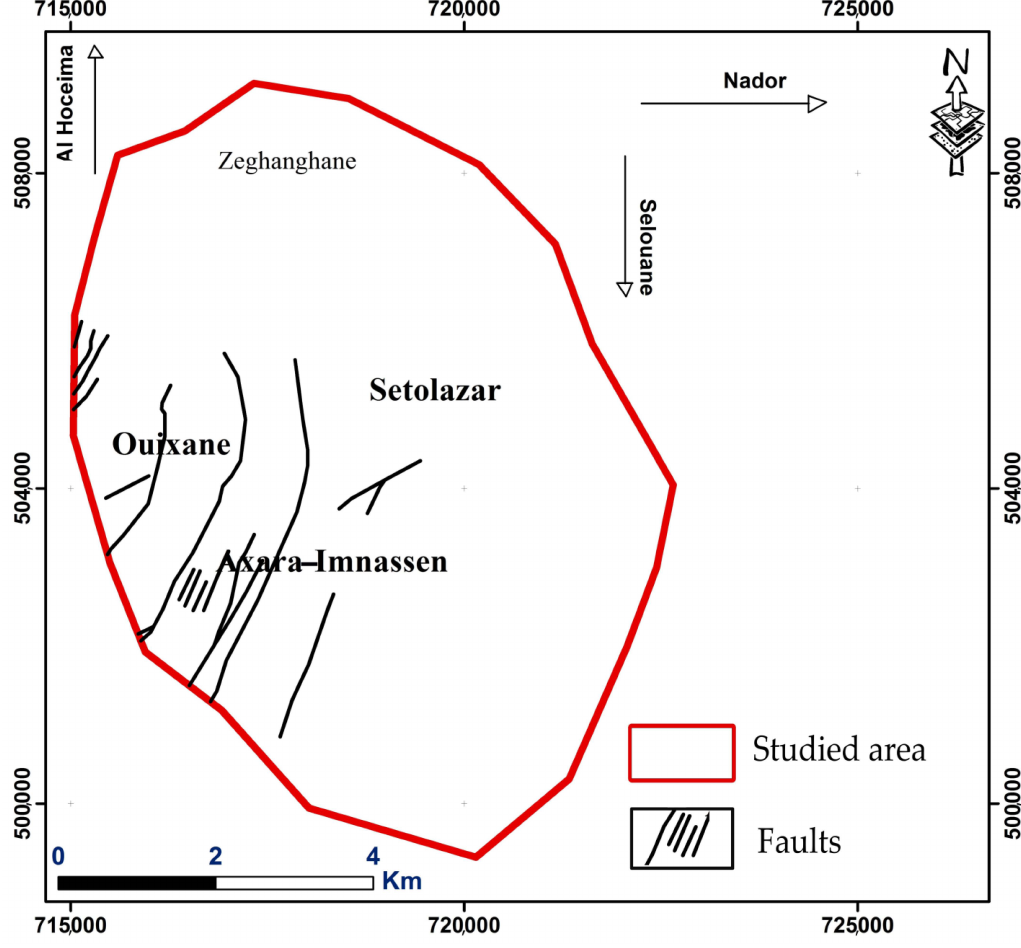
Figure 12. Main geologic faults crossing the iron mining district of